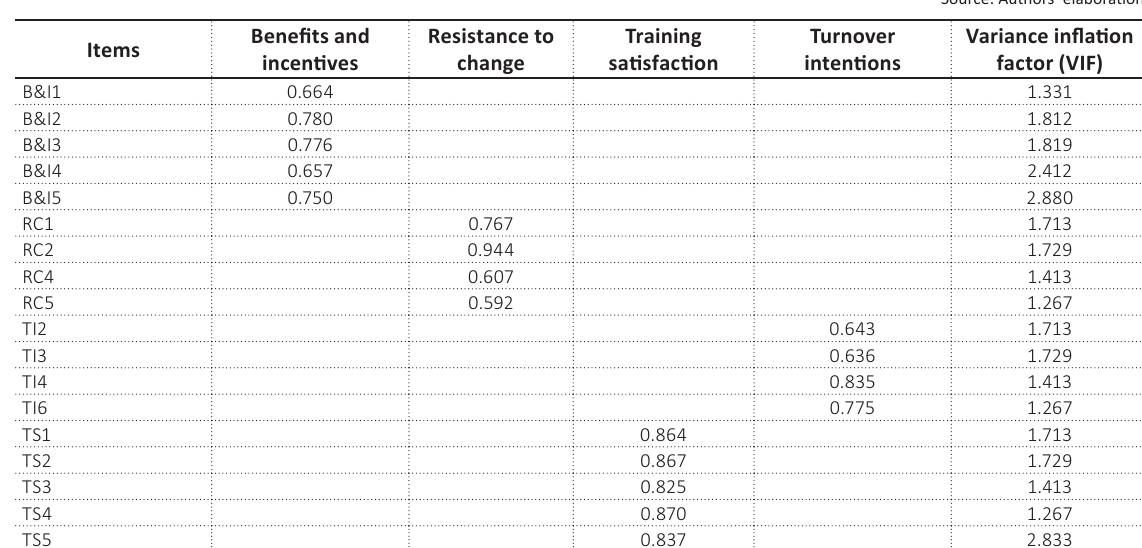
Table 4. Factor loadings and multicollinearity (VIF)